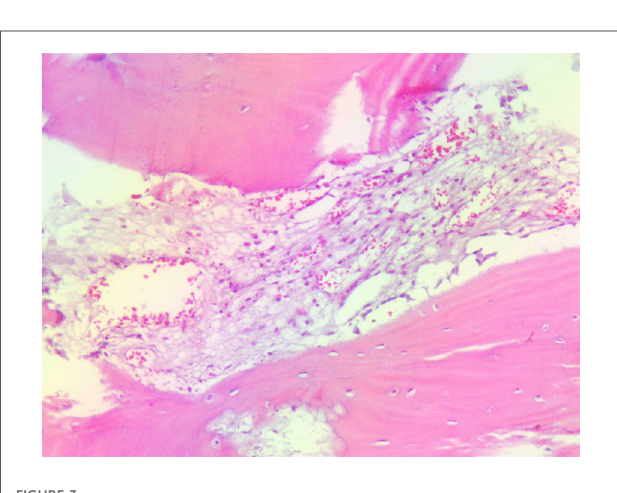
FIGURE 3 Histopathological examination of a biopsy in the right femur reveals small fragments of destroyed trabeculae with osteoclasts and proliferating thin- walled blood